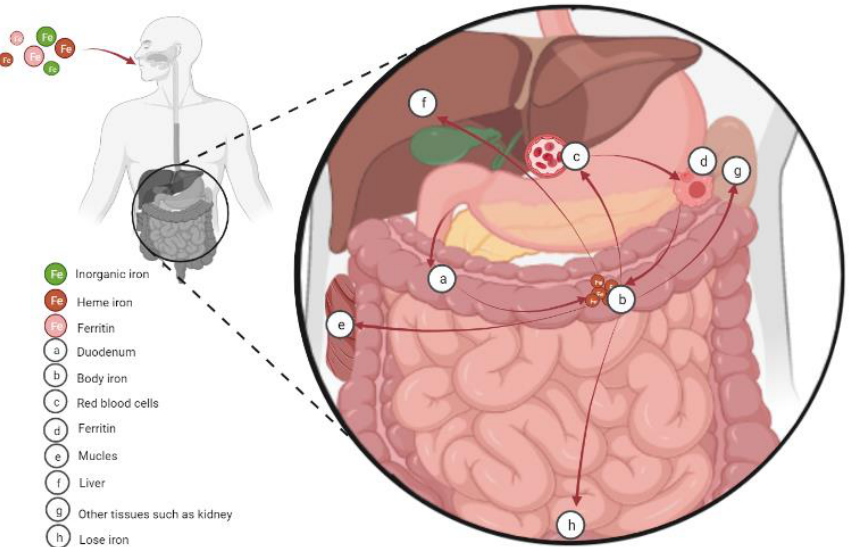
Figure 1. Cellular iron absorption, utilization, and homeostasis. Dietary iron is absorbed in the duodenum in the following three forms: inorganic (mainly present in the oxidized form Fe 3+ ), heme, and ferritin. Then the iron is transported to the body. Body iron is mainly present in the hemoglobin of red blood cells and developing erythroid cells (at least 2.1 g in humans). In addition, macrophages (up to 600 mg) and the myoglobin of muscles (~300 mg) also contain significant amounts of iron, and the liver stores the excess body iron (~1 g). Other tissues also contain lower, but not negligible, quantities of iron. Finally, mammals lose iron from sloughing of mucosal and skin cells or during bleeding.